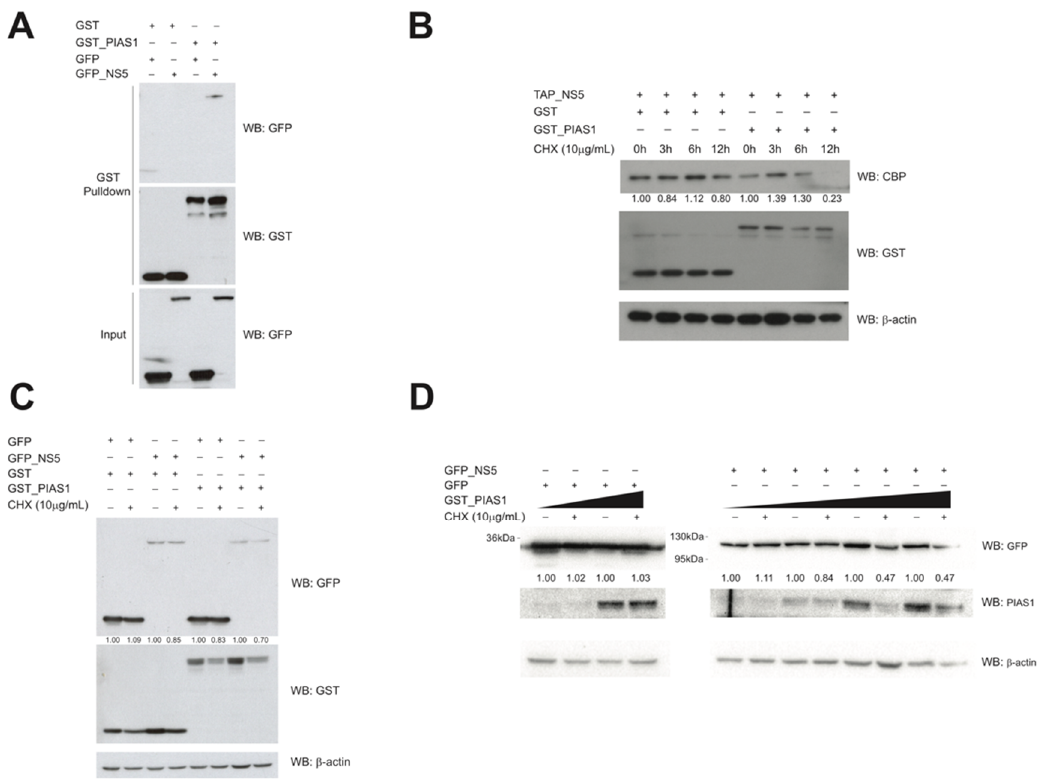
Figure 6. PIAS1 interacts with and modulates ZIKV NS5 protein stability. ( A ) GST pulldown was conducted using whole cell lysates of HEK293FT cells transfected with GST-tagged PIAS1 and GFP-tagged NS5 (empty vectors were used as negative controls). Input represents 10% of the lysate used in the GST pulldown assay. ( B ) HEK293FT cells transfected with GST-tagged constructs (empty vector or PIAS1) and pNTAP NS5 and treated with 10 µg/mL cyclohexamide (CHX) for the indicated time points. ( C ) HEK203FT cells transfected with GST and GFP-tagged constructs. Cells were treated, 24 h after transfections, with 10 µg/mL cyclohexamide (CHX) for 12 h. ( D ) HEK293FT cells were transfected with GFP-tagged constructs (empty vector or NS5) and different amounts of GST-tagged PIAS1 cDNA (0.5 µg, 1 µg, 2 µg, or 4 µg). pQCXIH was used to normalize the amount of transfected DNA. At 20 h post-transfection, cells were treated with 10 µg/mL cyclohexamide (CHX) for 12 h. + and – signs indicate presence or absence of the reagent indicated on the left, respectively.